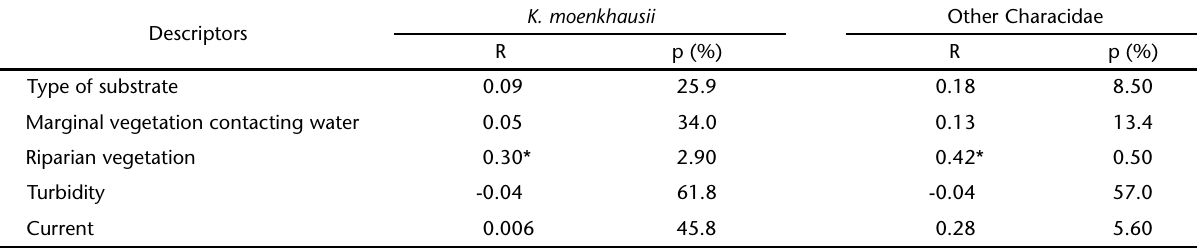
Table IV. ANOSIM summaries for environmental descriptors and species diet. R is a samples separation comparative measure, which varies from -1 to 1 (values close to zero indicate null hypothesis acceptance), p is the percentage of error Type I risk occurrence. * Significative